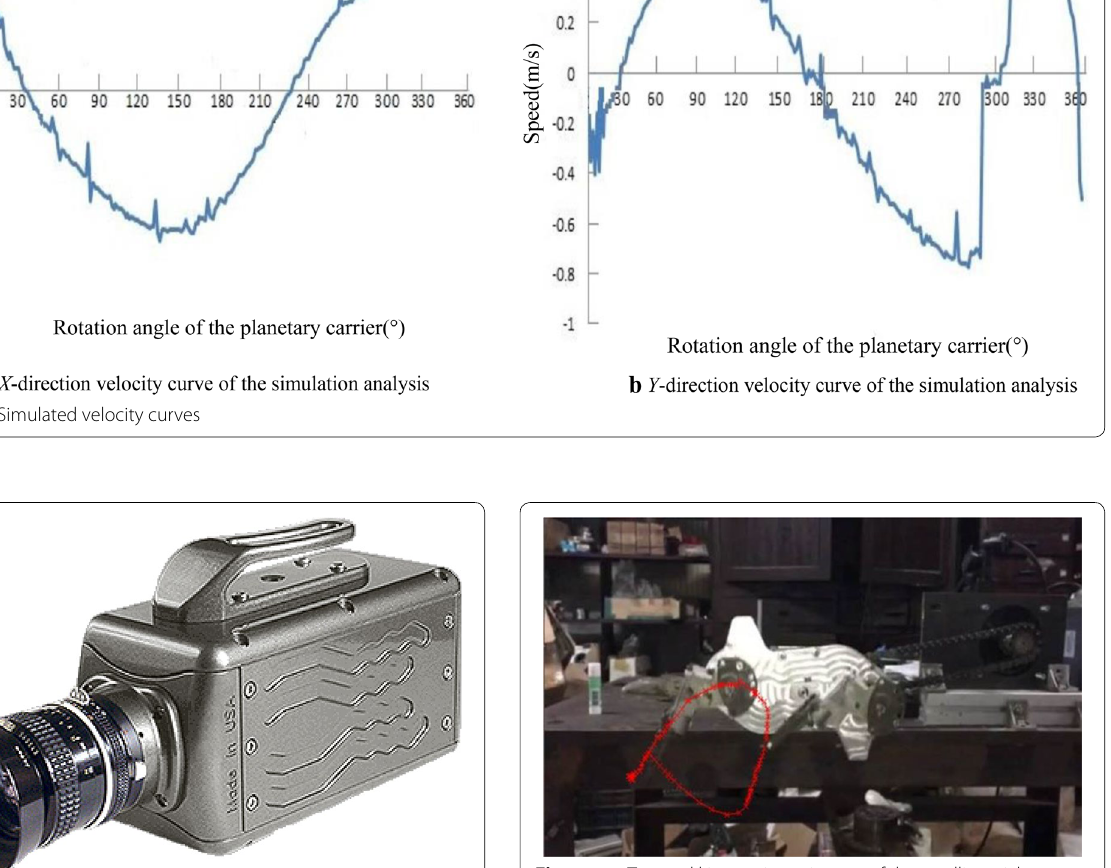
Figure 11 Test and kinematics trajectory of the seedling pick-up mechanism